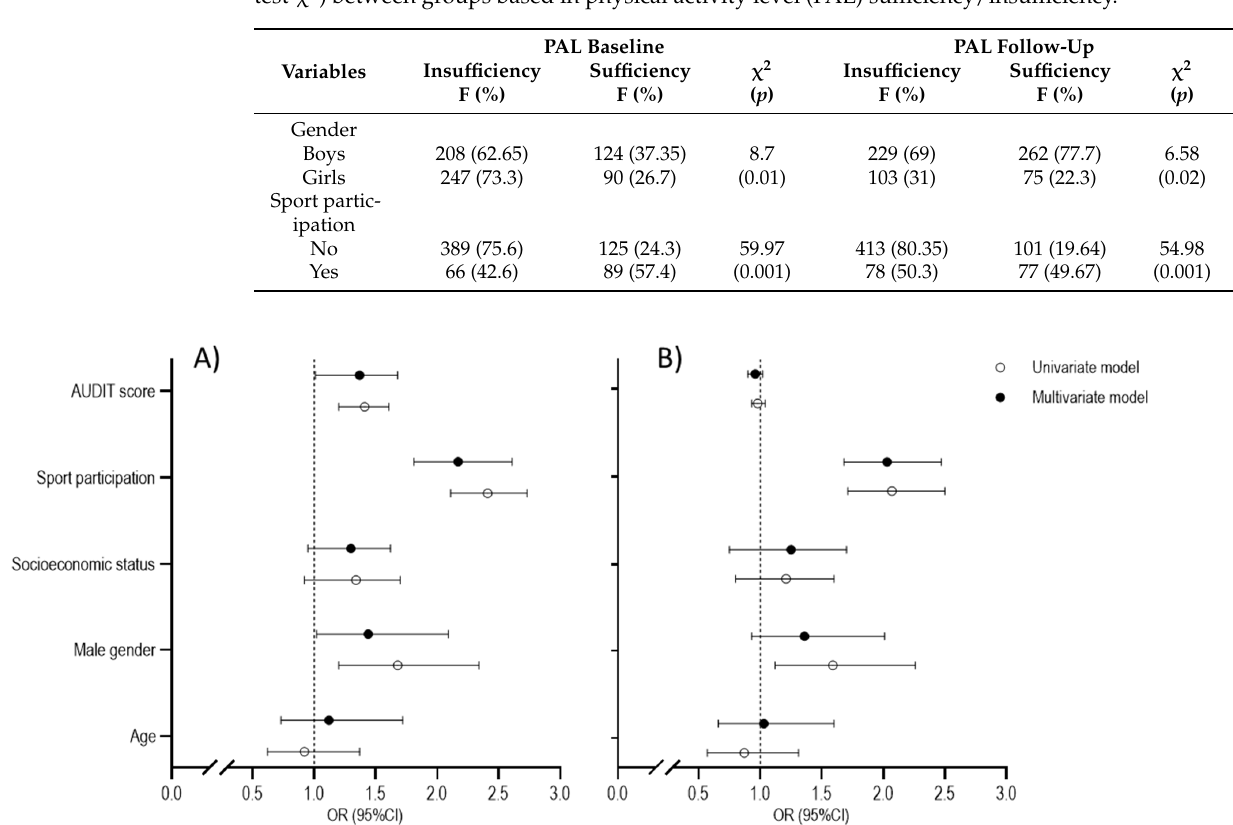
Figure 2. Descriptive statistics (means ± standard deviations) and t-test significance within groups for physical activity level for total sample ( A ), boys ( B ), and girls ( C ): *** p < 0.001). Table 1. Descriptive statistics (frequencies (F) and percentages (%)) and differences (Chi-square